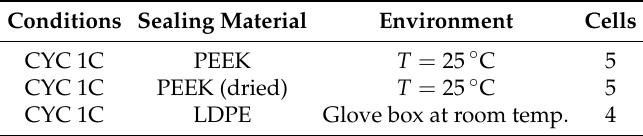
Table 4. Conducted sealing measurements: Two aging tests with modified material (PEEK, PEEK (dried)) and a test with LDPE sealing rings inside the glove box. The drying is carried out at T = 80 ◦ C for t = 24h. Conditions Sealing Material Environment